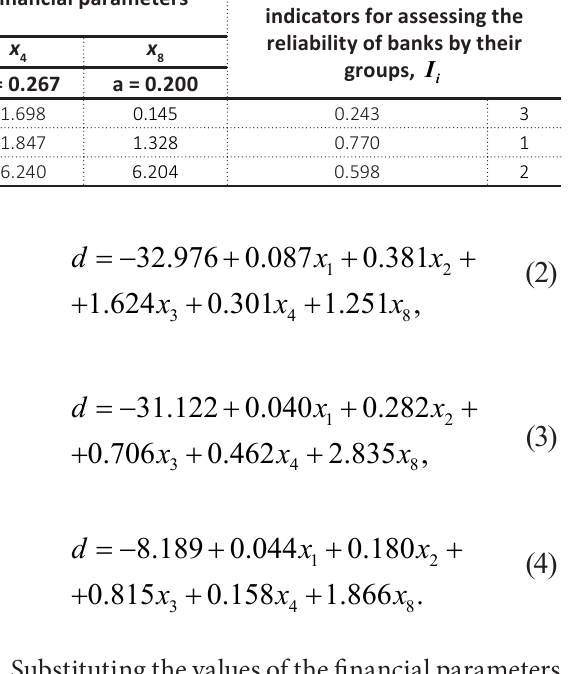
Source: Own processing. indicators for assessing the reliability of banks by